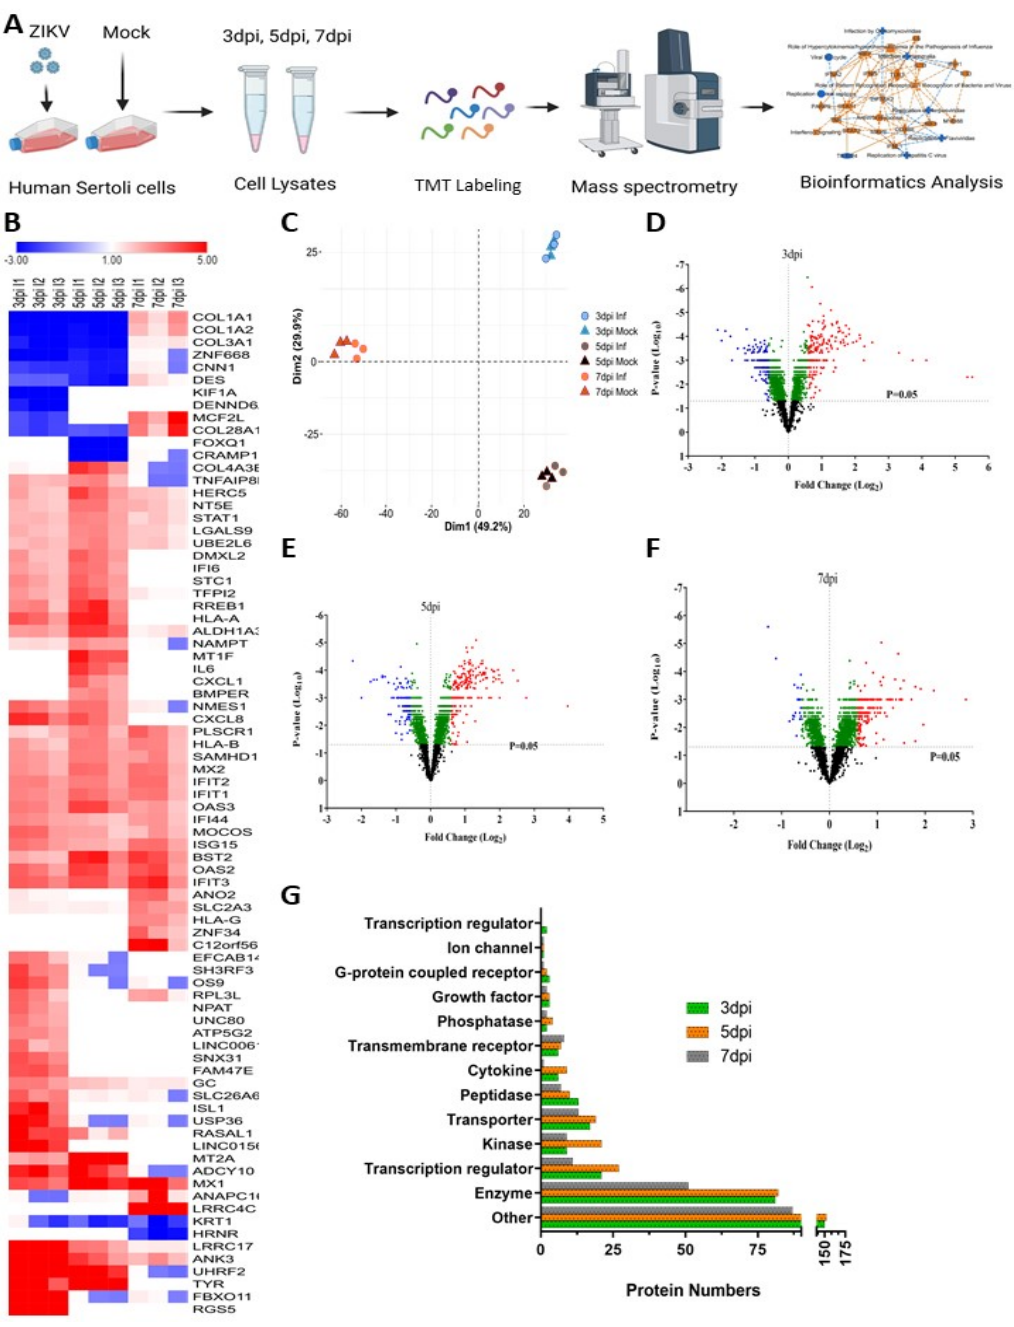
Figure 2. Detection of cellular protein level alterations in ZIKV ‐ infected Sertoli cells by mass spectrometry. ( A ) Schematic flow diagram of the study design. ( B ) Heatmap of most affected proteins (Fold change ≥ 2.5 or ≤ − 2.5; p value< 0.05) by ZIKV infection in Sertoli cells. Red and blue colors indicate up ‐ regulation and down ‐ regulation, respectively. ( C ) PCA plot of proteomic data from mock ‐ and ZIKV ‐ infected cells, from all three replicates. Volcano plots displaying the protein level alterations after ZIKV infection at 3 dpi ( D ), 5 dpi ( E ), and 7 dpi ( F ). Red = significantly up ‐ regulated (FC > 1.5; p ‐ value < 0.05), blue = significantly down ‐ regulated (FC < − 1.5; p ‐ value < 0.05), green = significantly affected ( p ‐ value < 0.05, but FC < ±1.5), black = not significantly affected ( p ‐ value > 0.05). ( G ) Classification of significantly altered (Fold change ≥ 1.5 or ≤ − 1.5; p value < 0.05) protein types at different time points after ZIKV infection. Abbreviations. FC = Fold change; dpi = Days post infection; inf = Infected.